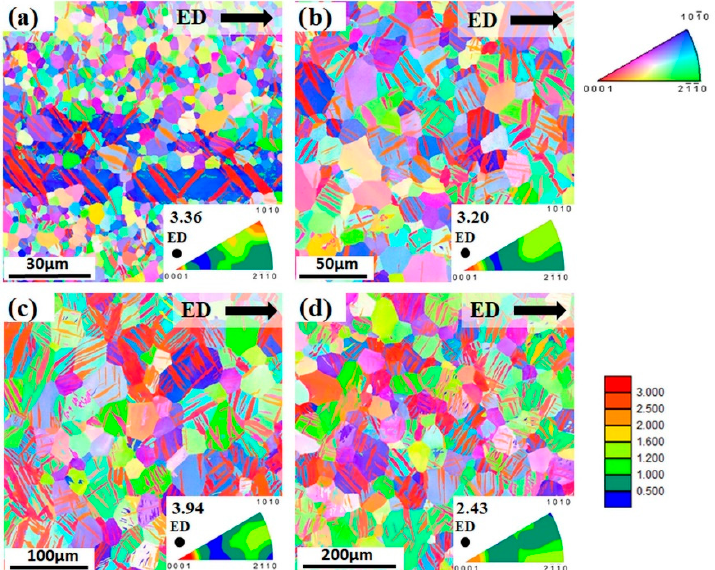
Figure 4. Microstructure of the precompressed extruded alloy: ( a ) ZX10-04, ( b ) ZX10-11, ( c ) ZX10-23, ( d ) ZX10-53 measured at longitudinal section (ED is horizontal). Colour code used for orientation maps is represented along ED. Triangular inverse pole figure (IPF) in each subfigure represents texture of the alloy along ED (i.e., ED is perpendicular to IPF).